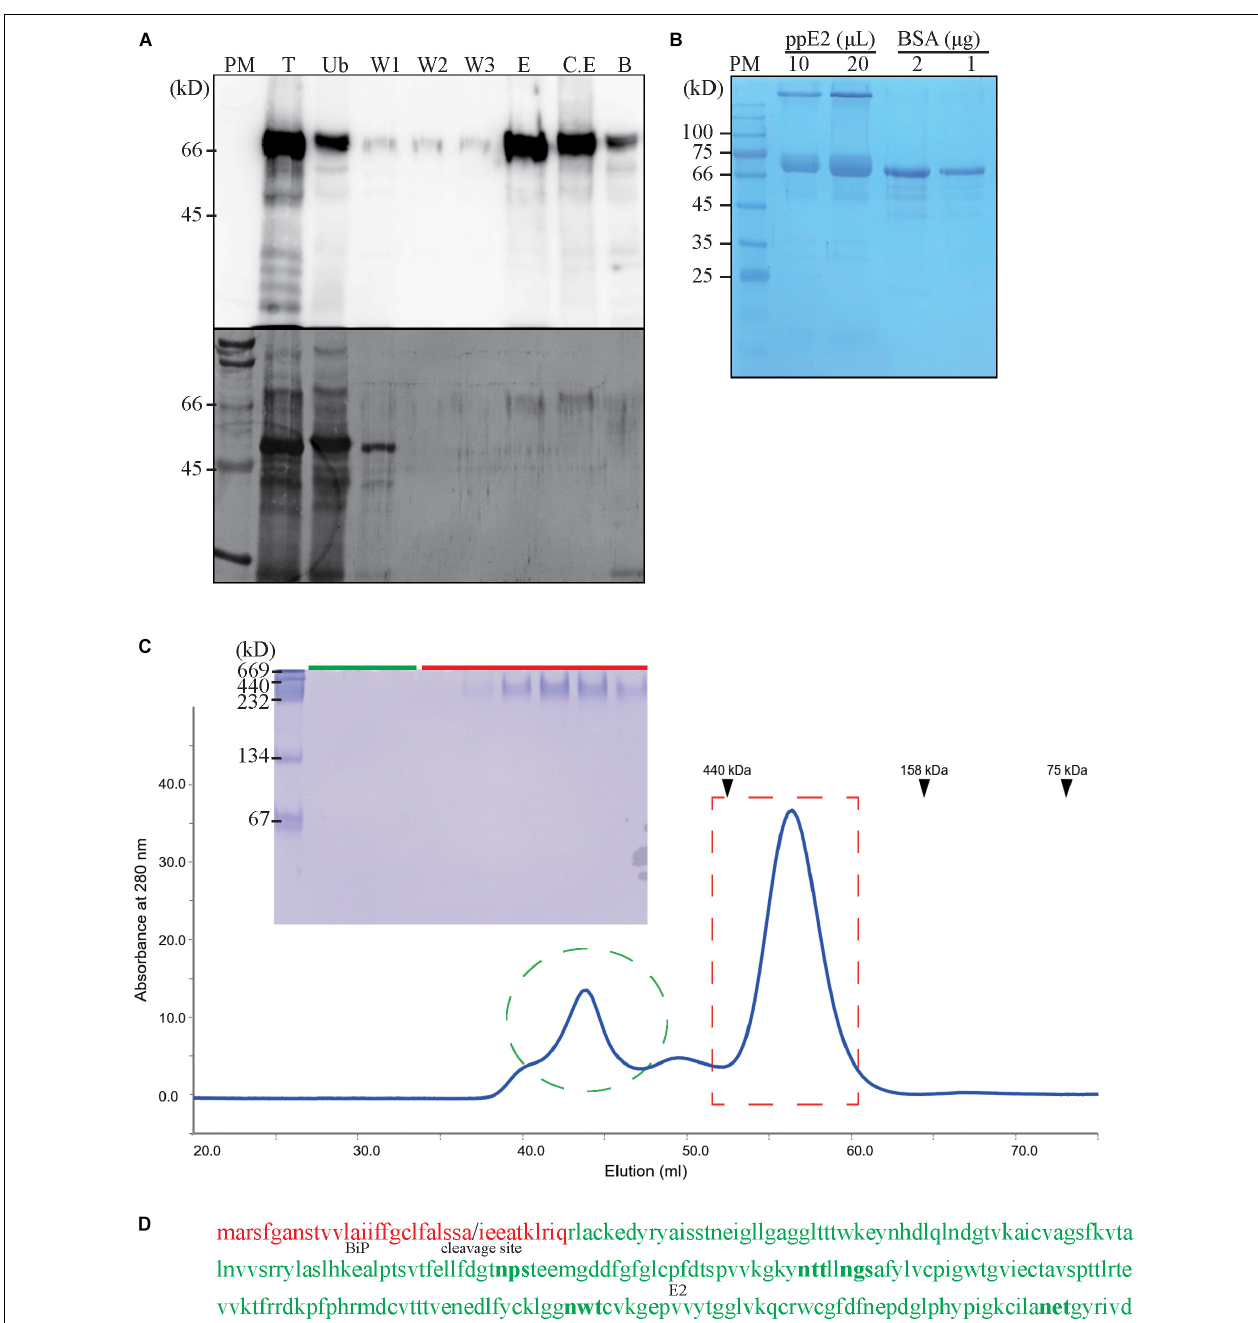
FIGURE 3 | Purification and identity confirmation of recombinant E2 fusion protein. (A) Purification of plant-produced E2 fusion protein (ppE2). Protein extracts prepared from fresh leaves of transgenic Nicotiana benthamiana (1 g leaves/5 ml extraction buffer) were loaded onto a column containing 0.2 g of cellulose beads. The column was washed three times, and wash-off fractions were collected. Proteins were eluted with 2 × 5 ml of elution buffer. Aliquots of total protein (T), unbound fraction (Ub), wash-off fractions (W1–W3), and elution fractions (E1 and E2), as well as the post-elution cellulose-bead contents, were analyzed by